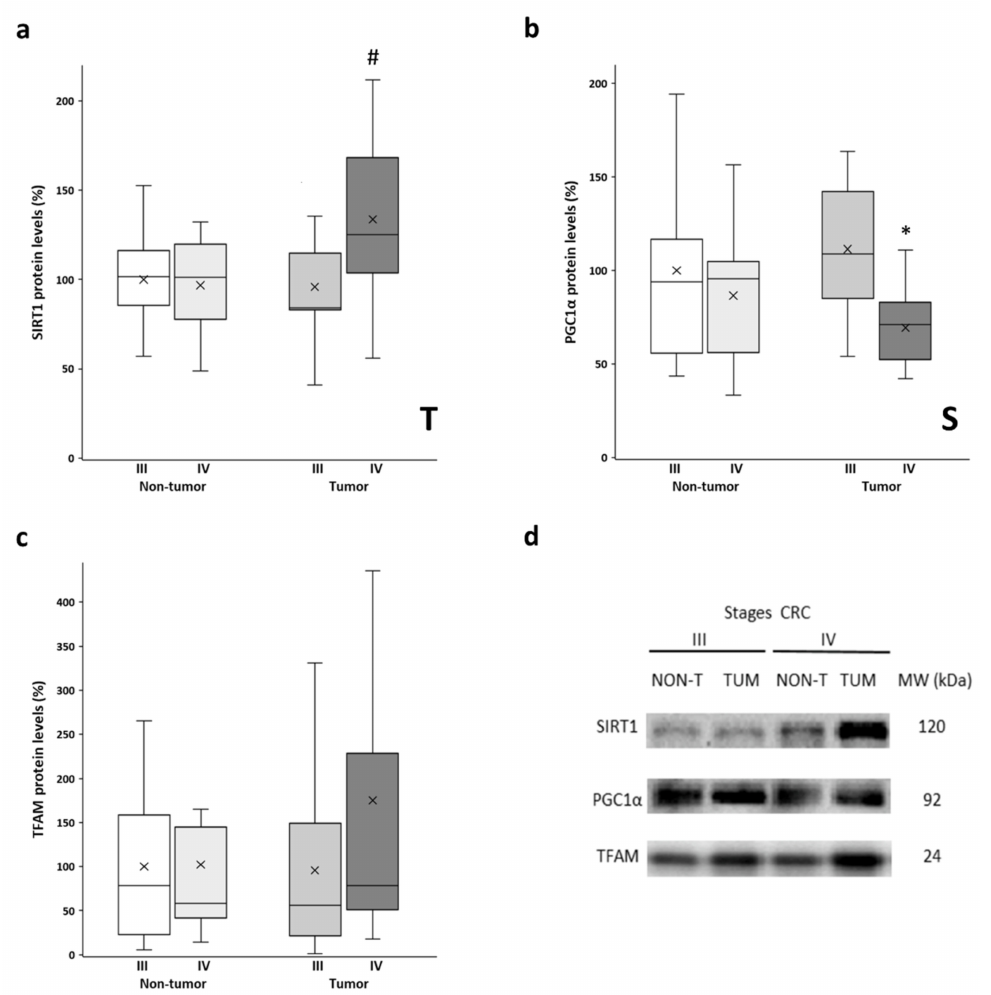
Figure 3. Boxplot of the protein levels of SIRT1 ( a ), PGC1 α ( b ), and TFAM ( c ). The X in each boxplot represents the mean. ANOVA analysis: two-way ( n = 11 per group): T, tissue effect; S, stage effect; one-way ( n = 11 per group): * differences between stage III and stage IV, # differences between non-tumor adjacent tissue and tumor tissue; ( d ) Representative bands of SIRT1, PGC1 α , and TFAM; NON-T, non-tumor adjacent tissue; TUM, tumor